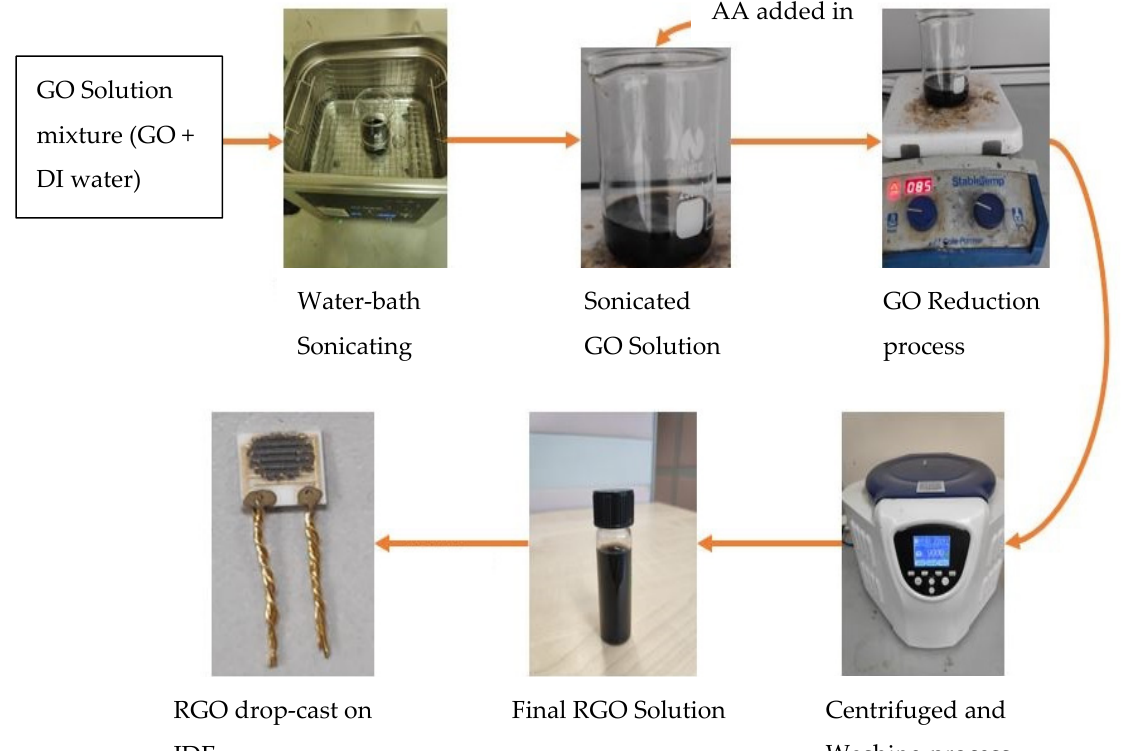
Figure 4. Illustration of RGO Preparation process from GO.